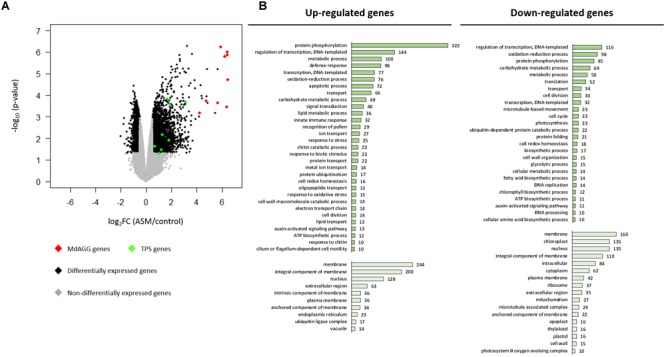
Apple leaf transcriptome remodeling by ASM treatment. (A) Volcano plot representing gene expression modulation 3 days after ASM treatment. Each scattered point represents a single gene: the x coordinates corresponds to the log2 fold change (log2FC) of the expression ratio between ASM- and control-treated plants; the y coordinates correspond to –log10 of the p-value (n = 4 samples per treatment from four independent experiments). Genes involved in the terpene and agglutinin pathways are highlighted in green and red, respectively. (B) Selected results (gene number > 10 and hypergeometric test ≤ 0.05) of Gene Ontology terms over-representation analysis for up- (left panels) and down-regulated genes (right panels). Dark green barplots represent Biological Process (BP) and light green barplots Cellular Component (CC). X-axis corresponds to the number of genes differentially expressed included in each category.